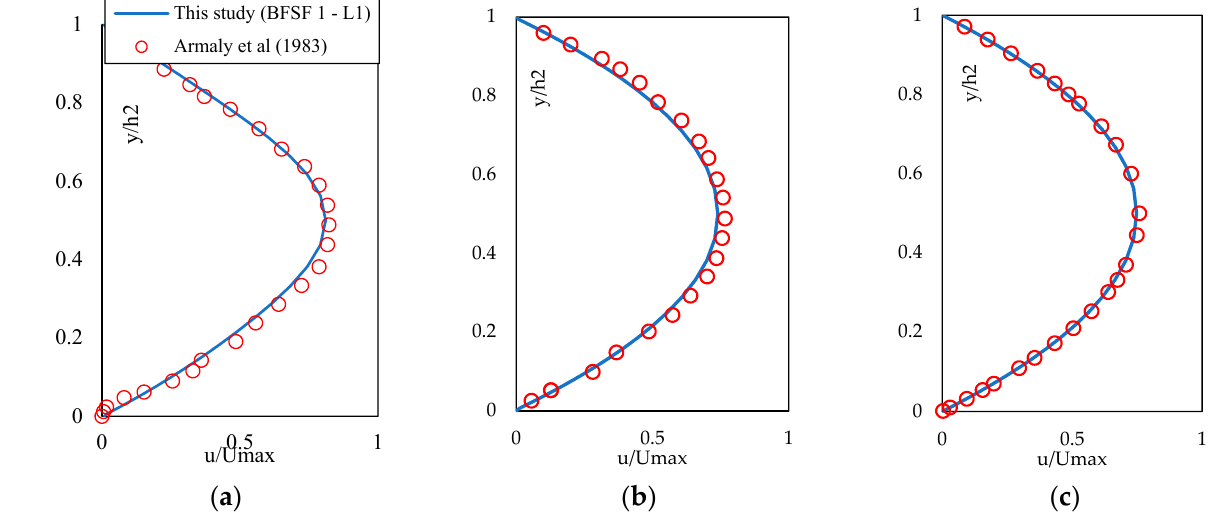
Figure 6. Dimensionless u-velocity profiles (u/U max ) at Re h = 75. ( a ) x/h = 4.8, ( b ) x/h = 12.04, ( c ) x/h = 30.31 [3].